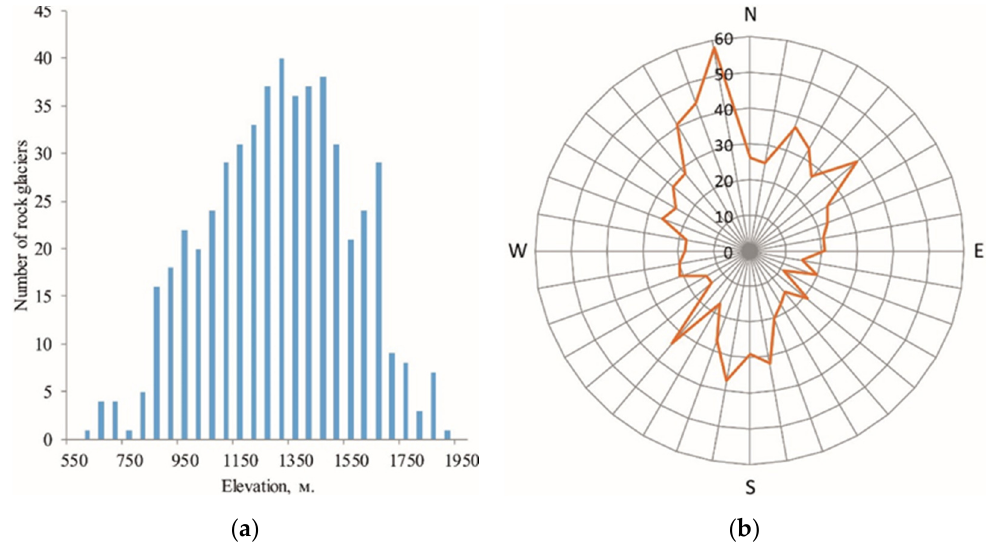
Figure 6. Distribution of mean absolute altitudes ( a ) and exposure of slopes ( b ) and rock glaciers of the Momsky Range.